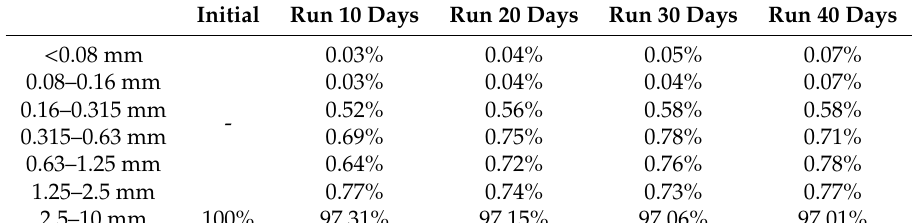
Table 6. Change in particle size distribution of drainage layer filler during operation.